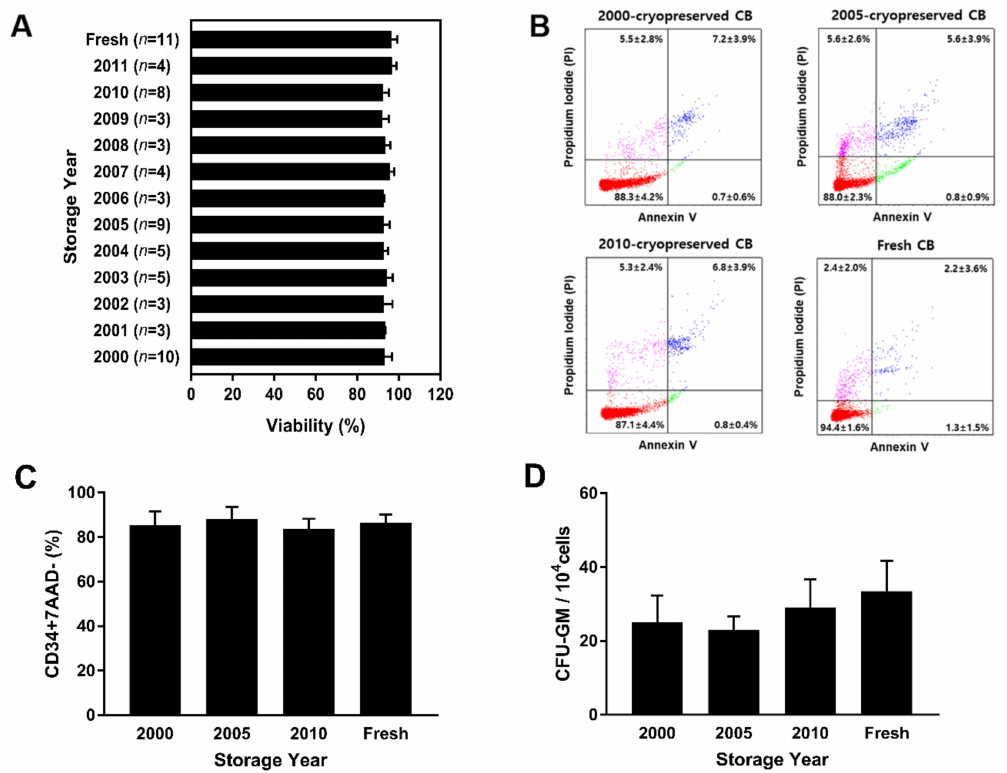
Figure 2. Comparison of MNC viability in long-term cryopreserved and fresh umbilical CB samples by Annexin V/propidium iodide staining. ( A ) After RBC depletion and Ficoll separation, MNC viability was assessed in 60 cry- opreserved CB units (stored from 2000 to 2011) and 11 fresh CB units. There was no significant difference between MNC viabilities in cryopreserved and fresh CB units ( p > 0.99). The average viability percentage was 93.6 ± 1.4%. ( B ) Annexin V/propidium iodide staining revealed that there was no correlation between cryopreservation period and cell viability. ( C ) The viability of CD34+ cells in cryopreserved (3 units stored from 2000, 2005, and 2010) and fresh CB (3 units) was analyzed by flow cytometry with 7-AAD staining. ( D ) In vitro CFU-GM assay provided the colony number of granulocyte- macrophage progenitor cells for 14-day culture period ( p = 0.32). Data are presented as mean ± standard deviation of mean. Abbreviations: CB, cord blood; MNCs, mononuclear cells; 7-AAD, 7-Aminoactinomycin; CFU-GM: colony-forming unit-granulocyte,